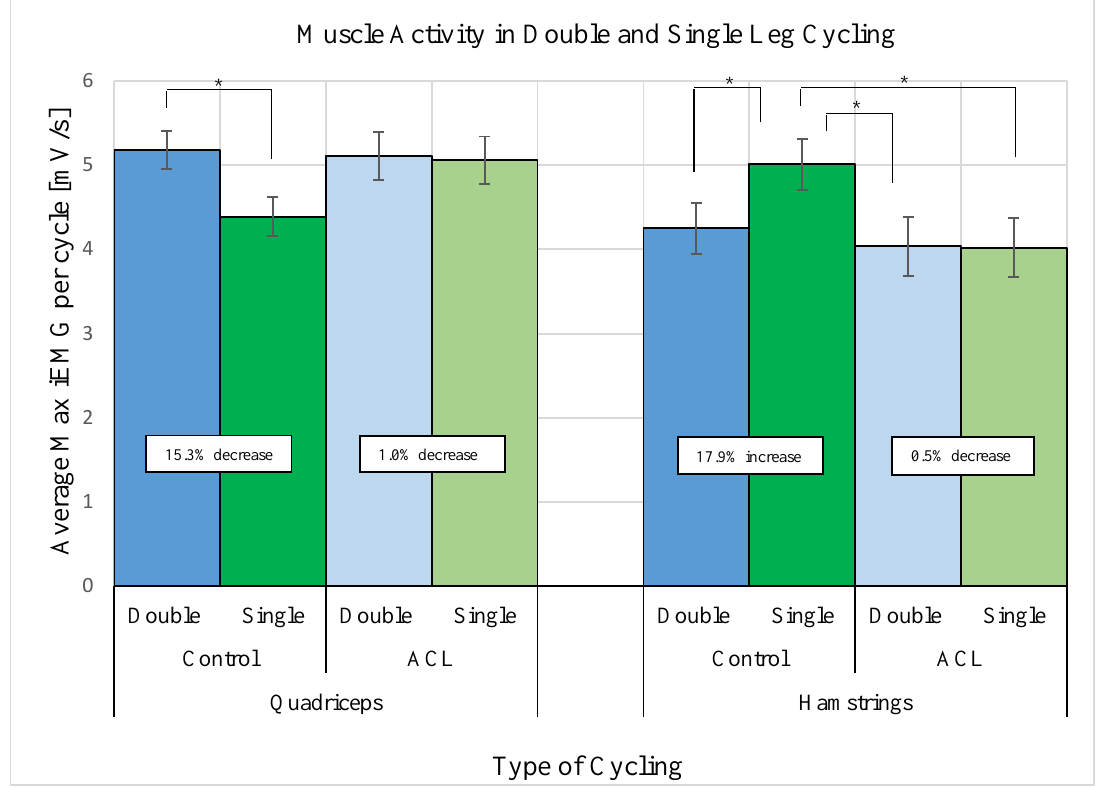
Figure 3. Average integrated EMG (significance ( p < 0.05) is noted with an asterisk).